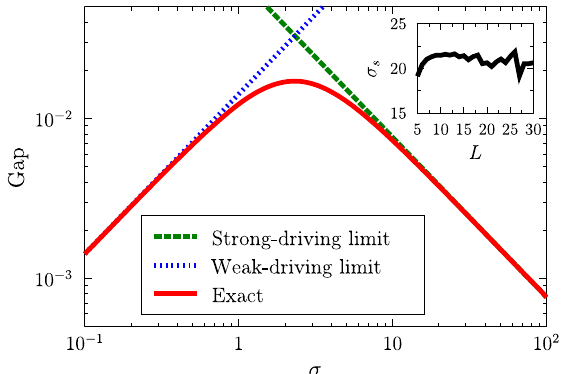
FIG. 3. Liouvillian gap for a controllable chain of L ¼ 10 as a function of the noise strength σ . Exact numerical results are obtained with q ¼ 1 . Strong-driving limit corresponds to Eq. (39), while the weak-driving limit is from Eq. (C12). Inset: Noise strength σ as a function of L such that, for σ > σ s ω Þ from relative error between the exact gap and the strong-coupling i ð estimate is smaller than and μ k ¼ 1 . k i